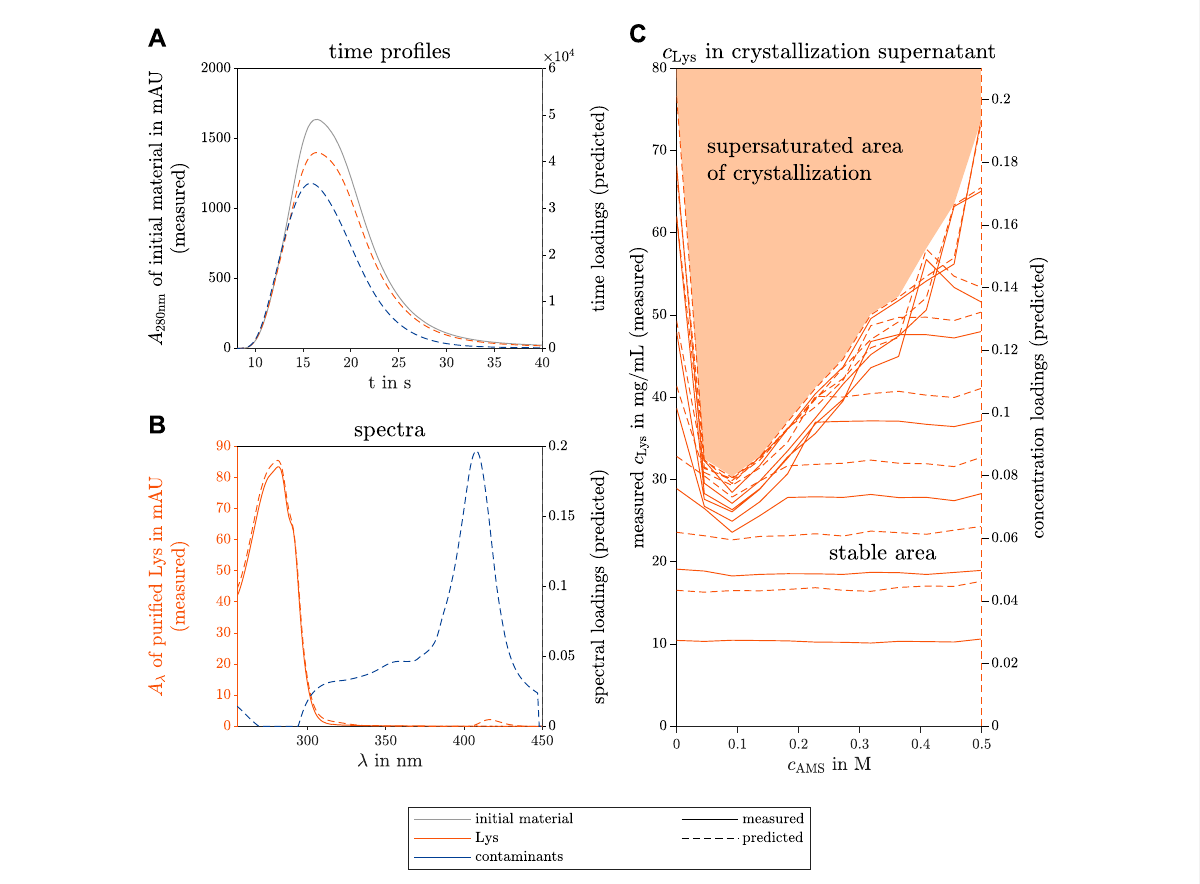
FIGURE 2 PARAFAC model results of the selective crystallization screening of Lys in a ternary model protein system. The measured reference data (left axis)andthepredictedloadings(rightaxis)areillustratedwithsolidanddashedlines,respectively.Thecolorsgray,orange,andblueindicatetheinitial raw material, the target species Lys, and the contaminating species, respectively. The time course loadings in (A) show the PARAFAC model predictions of the species absorption loadings over time t in the fl ow cell of the UV/Vis detector. Additionally, the spectral absorption of the initial solution A 280nm is shown at wavelength 280 nm over time. The spectral loadings in (B) demonstrate the similarity between the predicted and the measured Lys absorption spectra A λ over the wavelength λ . From the concentration loadings in (C) , the predicted saturation curve can describe the phase behavior of Lys in the investigated ternary model system and can distinguish the screened conditions into the supersaturation and stable area. The variables c Lys and c AMS represent the concentrations of Lys and AMS,